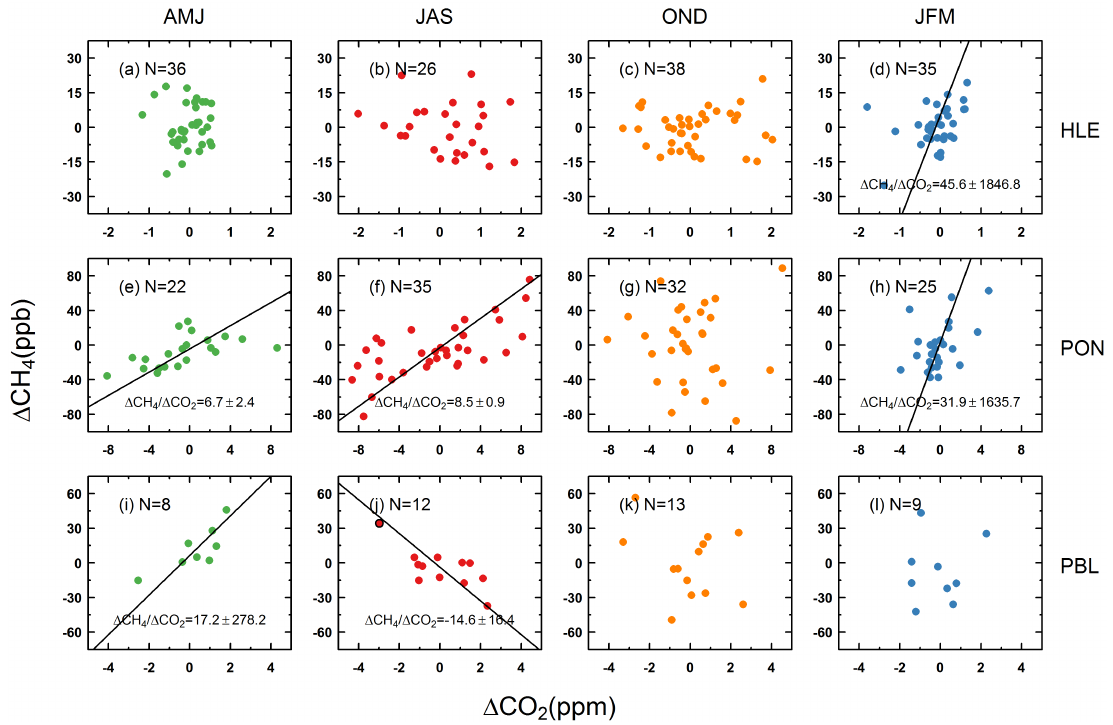
Figure 15. The relationships between (cid:49) CH 4 and (cid:49) CO 2 at HLE (a–d) , PON (e–h) , and PBL (i–l) for April–June (AMJ), July–September (JAS), October–December (OND), and January–March (JFM). For each panel, (cid:49) CH 4 and (cid:49) CO 2 are estimated as residuals from smoothed curves. The (cid:49) CH 4 /(cid:49) CO 2 ratio is the slope of the fitting line from the orthogonal distance regression, with the SD calculated from 1000 bootstrap replications. For (cid:49) CH 4 and (cid:49) CO 2 values that are not significantly correlated, the fitting line is not